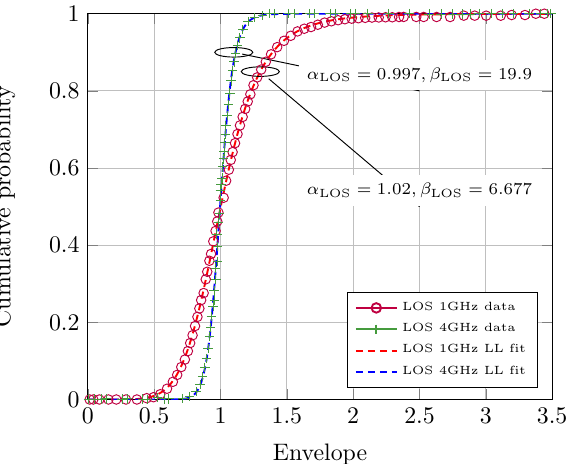
Figure 5. Statistical distributions of fast fading in UAV air-to-ground channels at 1 and 4 GHz, LOS scenario. Empirical CDF values were obtained from [15], whereas corrected fitting values for the LL distribution are provided here. Goodness-of-fit values are RMSE 1GHz = 3.92 × 10 − 3 and RMSE 4GHz = 1.1 × 10 − 2